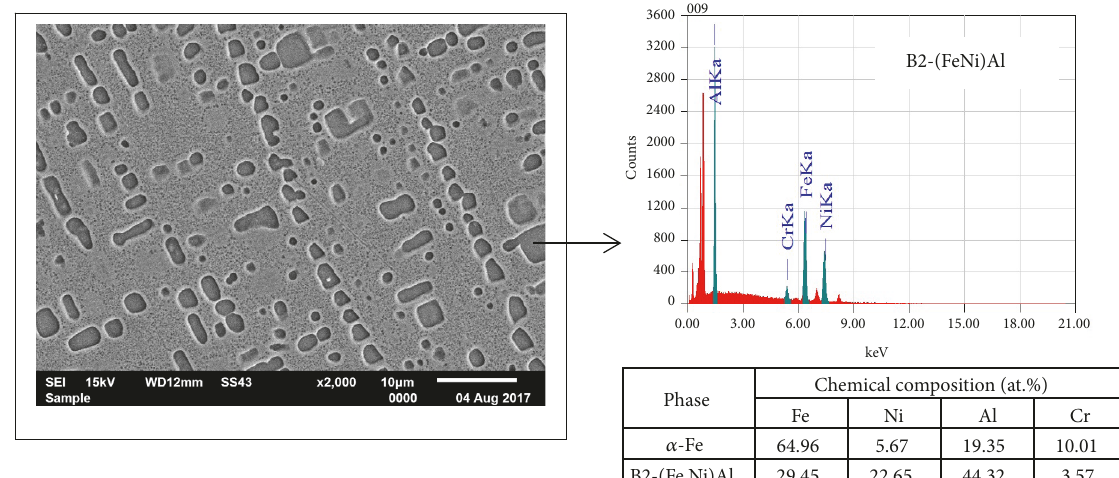
Figure 3: EDX analysis of phases in the substrate sample heated at 1000 ∘ C for 150